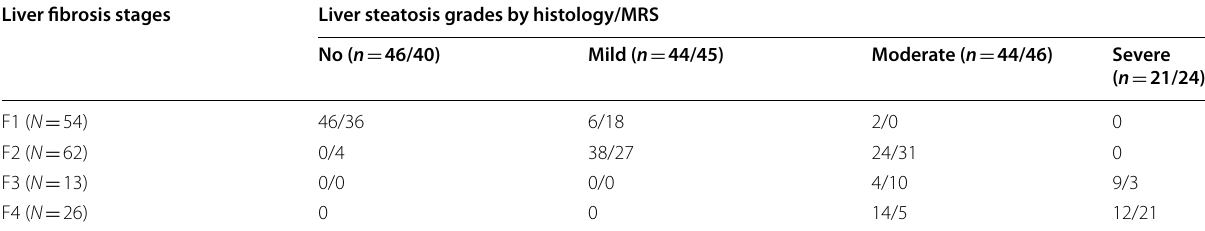
Table 4 Distribution of hepatic steatosis grade as assessed by histology /MRS in different fibrosis stages Liver fibrosis stages Liver steatosis grades by histology/MRS